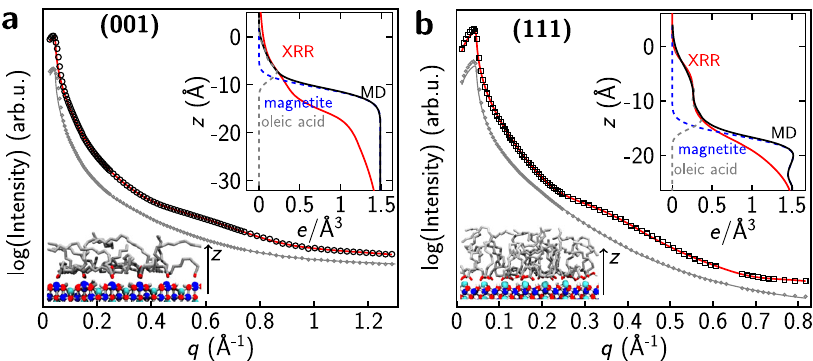
Fig. 3 OLAC layer properties investigated with XRR. XRR curves obtained on ( a ) magnetite (001) and ( b ) magnetite (111) before and after OLAC dosing (10 − 6 mbar, 60 min). The gray data points and solid lines depict the respective clean surface XRR data and fi t, while data points and fi t of the OLAC covered surfaces are shown in black and red, respectively. Curves shifted vertically for clari fi cation. Insets: Electron density pro fi les as a function of the distance perpendicular to the surface z . Experimentally calculated from the XRR fi t after OLAC (red line) and estimated for individual components, i.e., magnetite (dashed blue), OLAC (dashed gray), and total (solid black), from MD simulations using the Density Pro fi le Tool as discussed in the main text.